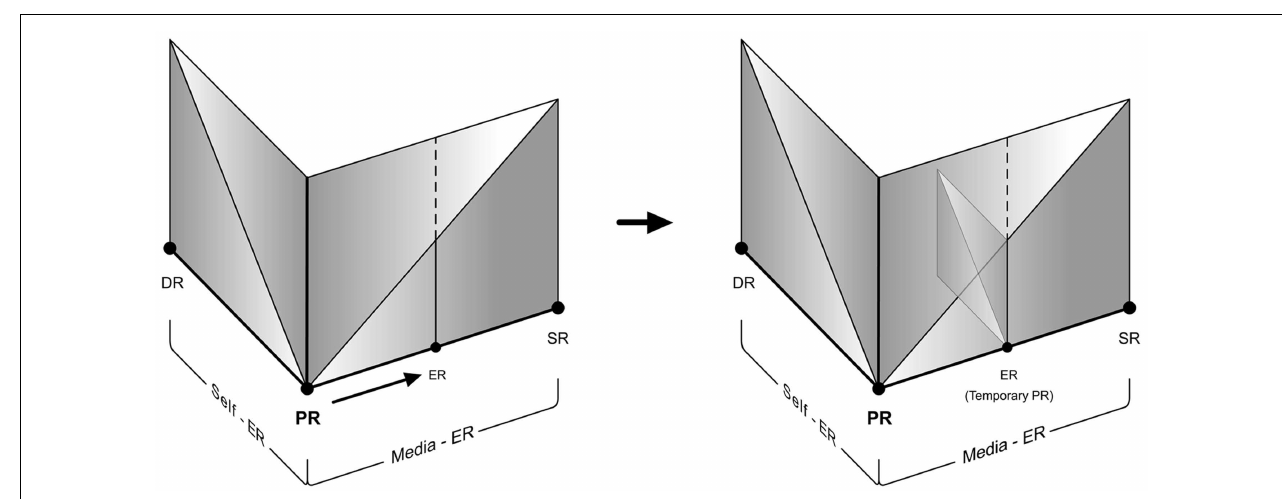
FIGURE 8 |An example of how Media-ER would temporarily act as a version of primary reality.